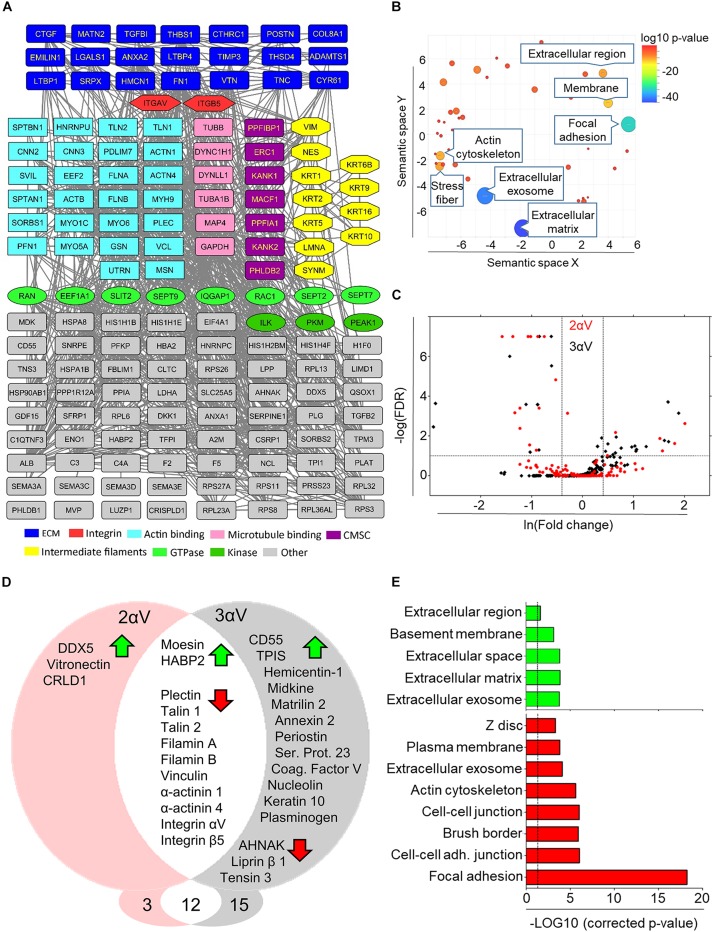
Mass spectrometry analysis of IACs isolated from MDA-MB-435S cells and clones 2αV and 3αV. (A) Protein–protein interaction network of components identified by MS in IACs isolated form MDA-MB-435S cells. Shapes represent identified proteins and are labeled with gene symbols, arranged and colored according to their functional group as indicated (CMSC). In case of multiple functional terms assigned for each protein, the molecular function assigned by both databases has been chosen for interpretation of results. (B) Total identified IAC proteins in MDA-MB-435S cells (number of spectral counts ≥ 4, FDR < 5%, probability for protein identification ≥ 99.9%) were annotated using David GO database. To determine the sample enrichment, P-values related to GO terms of cellular components (GOTERM_CC_DIRECT), were used. Analysis of gene ontology terms was performed using REViGO tool. Statistically significant GO terms (P = 0.05) were presented from highest P-value (bottom) to the lowest (top). (C) Volcano plot of MDA-MB-435S versus 2αV (red) and 3αV (black). To determine the significantly changed proteins −Log (FDR) ≥ 1 and fold change ≥ 1.5 were used. Upper left quadrant – proteins detected at lower level of spectra, upper right quadrant – proteins detected at higher level of spectra. (D) Venn diagram – proteins with higher (green arrow) and lower (red arrow) level of spectra detected in clones 2αV and 3αV versus MDA-MB-435S cells. Proteins found in both clones with changed abundances were showed in the intersected white area of the diagram. (E) DAVID GO analysis of proteins detected with higher (green arrow) and lower (red arrow) abundances. Statistically significant GO terms (P = 0.05; dashed line) were presented from highest P-value (bottom) to the lowest (top).